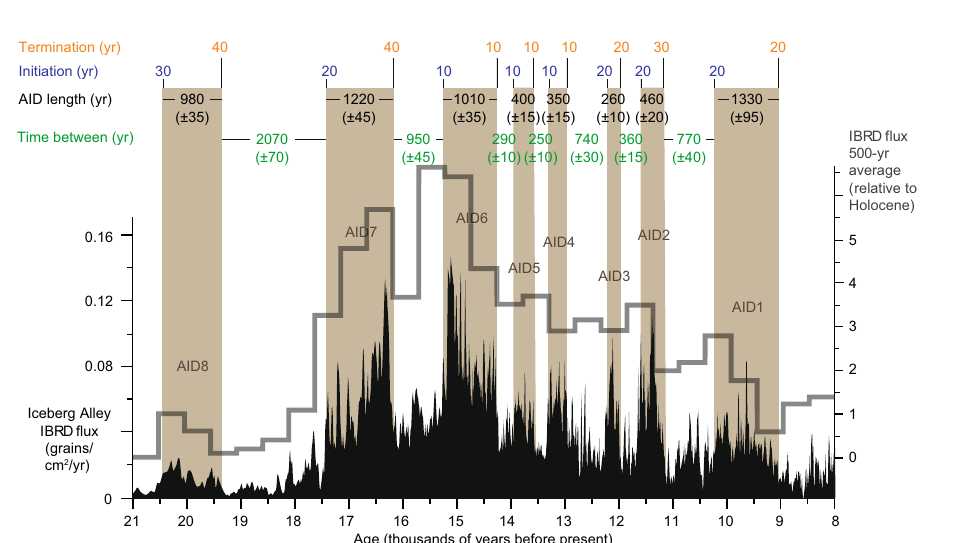
Fig. 3 Pace and duration of AID events. Deglacial iceberg-rafted debris (IBRD) stack from Iceberg Alley with Antarctic Ice-Sheet Discharge events AID1 – 8, sampled in 10-yr increments at Sites MD07-3133 and MD07-3134 and stacked (black curve) as well as displayed relative to Holocene average in 500-yr increments (gray histogram) on the AICC 2012 age scale 28,29 . AID events 1 – 8 (brown bars) destabilized the AIS within 10 – 30 years (blue numbers), and continued to retreat for 250 – 1160 years (black numbers). Consecutive AIS re-stabilization took 10 – 40 years (orange numbers), and remained for 190 – 2090 years (green numbers). Numbers in parenthesis indicate 2-sigma error for the duration of AID events. Note that the true pace of AIS destabilization might be less than a decade based on higher-resolution Site MD07-3133 (see